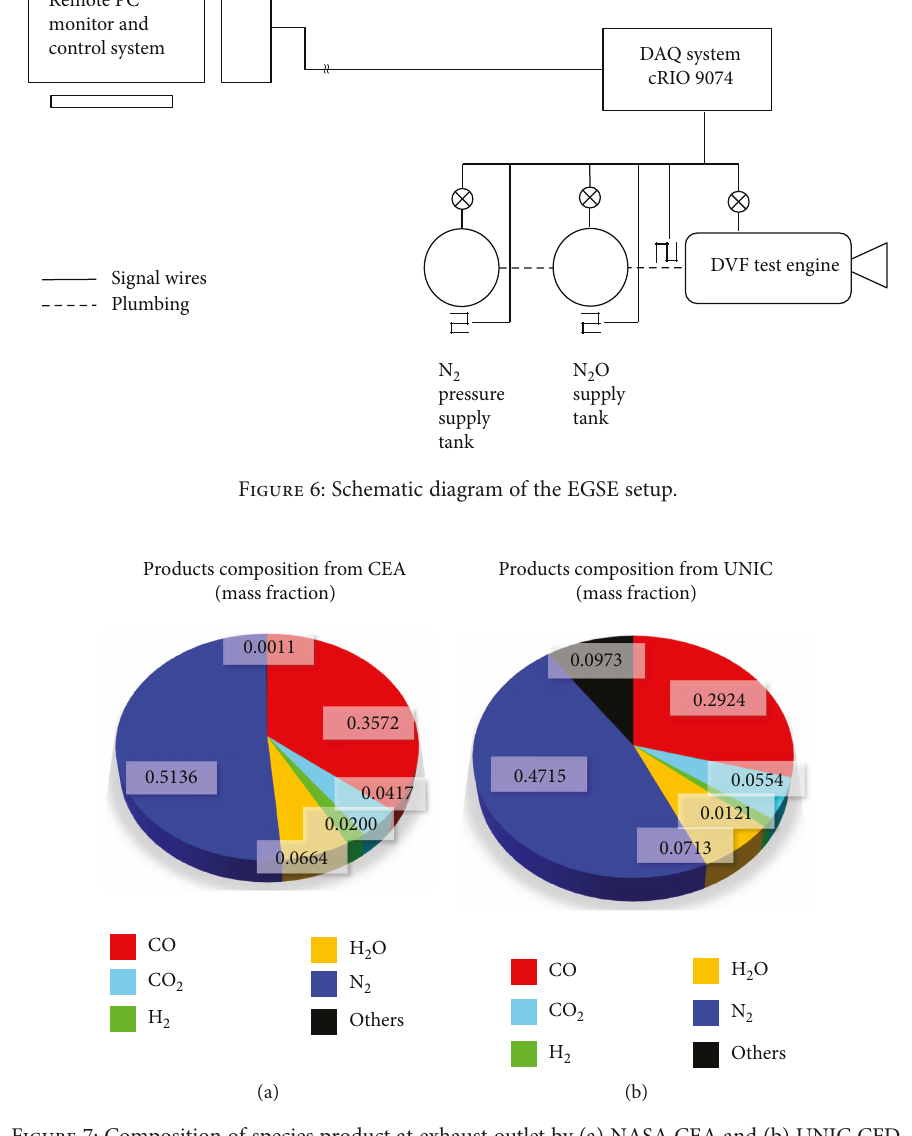
Figure 7: Composition of species product at exhaust outlet by (a) NASA CEA and (b) UNIC CFD.